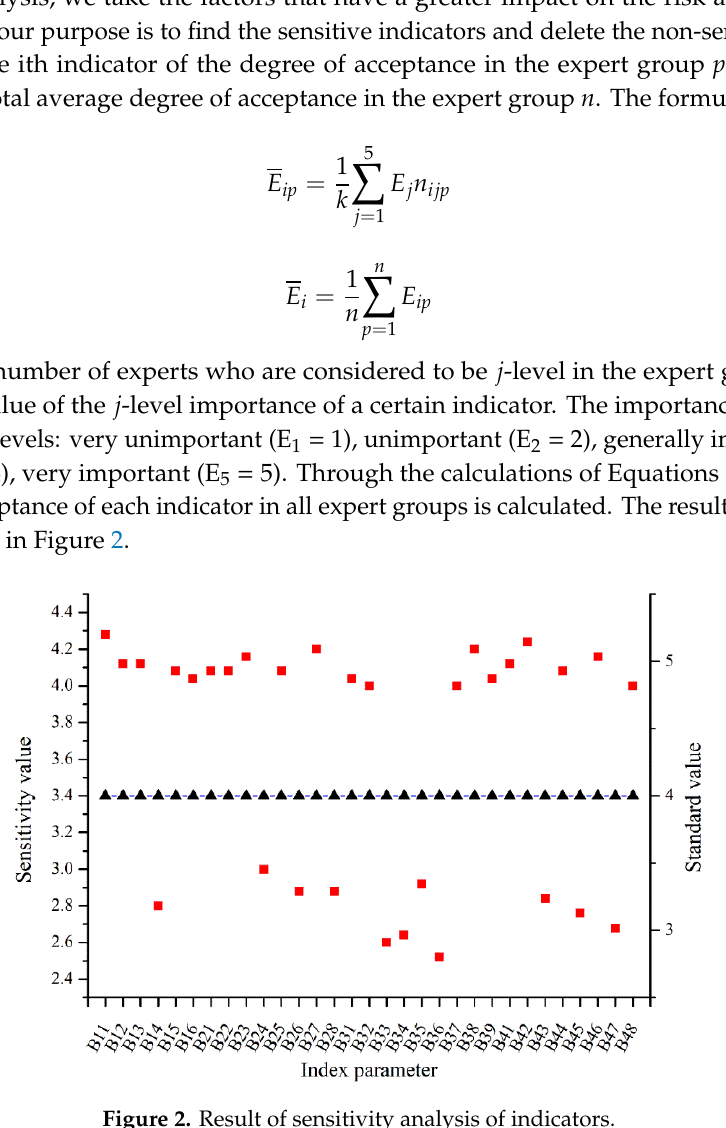
Figure 2. Result of sensitivity analysis of indicators.